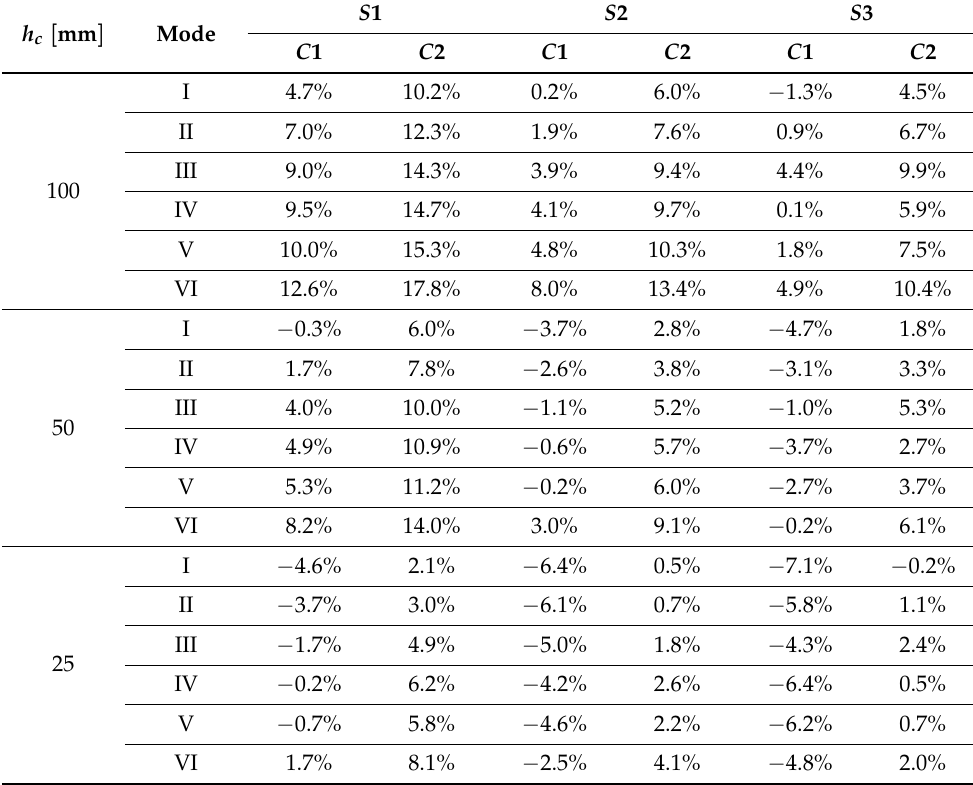
Table 2. The relative errors between averaged models and FEM model for a = 0.010